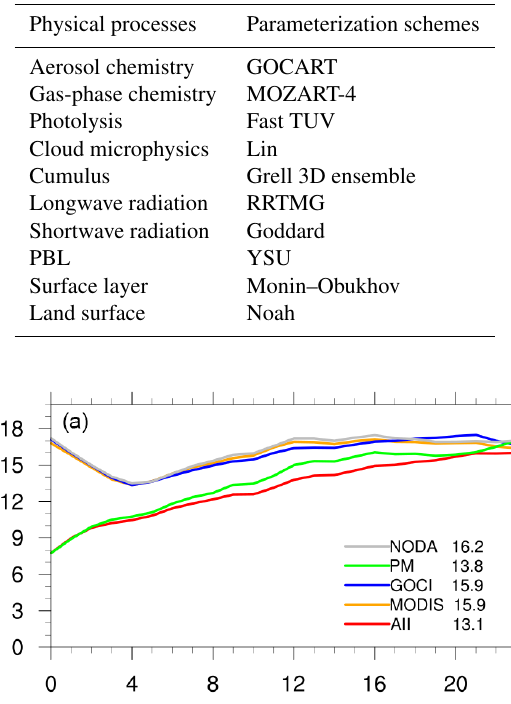
Table 1. Physical and chemical parameterizations used in the ex- periments.